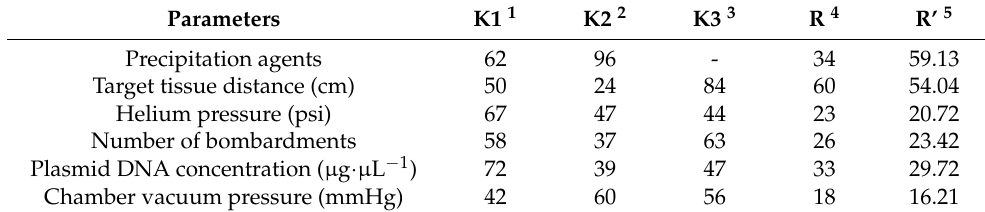
Table 4. Range analysis of different parameters.